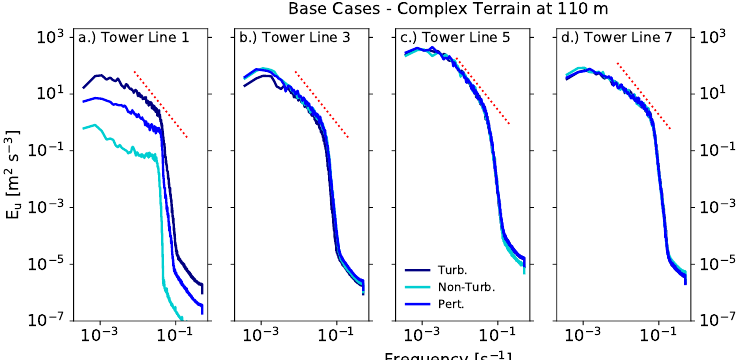
Figure 7. Tower line averaged spectra of the u -component wind speed for the CXT_base cases at tower lines 1, 3, 5, and 7 in panels ( a – d ), respectively, over complex terrain. The red dotted line indicates the − 5/3-slope.